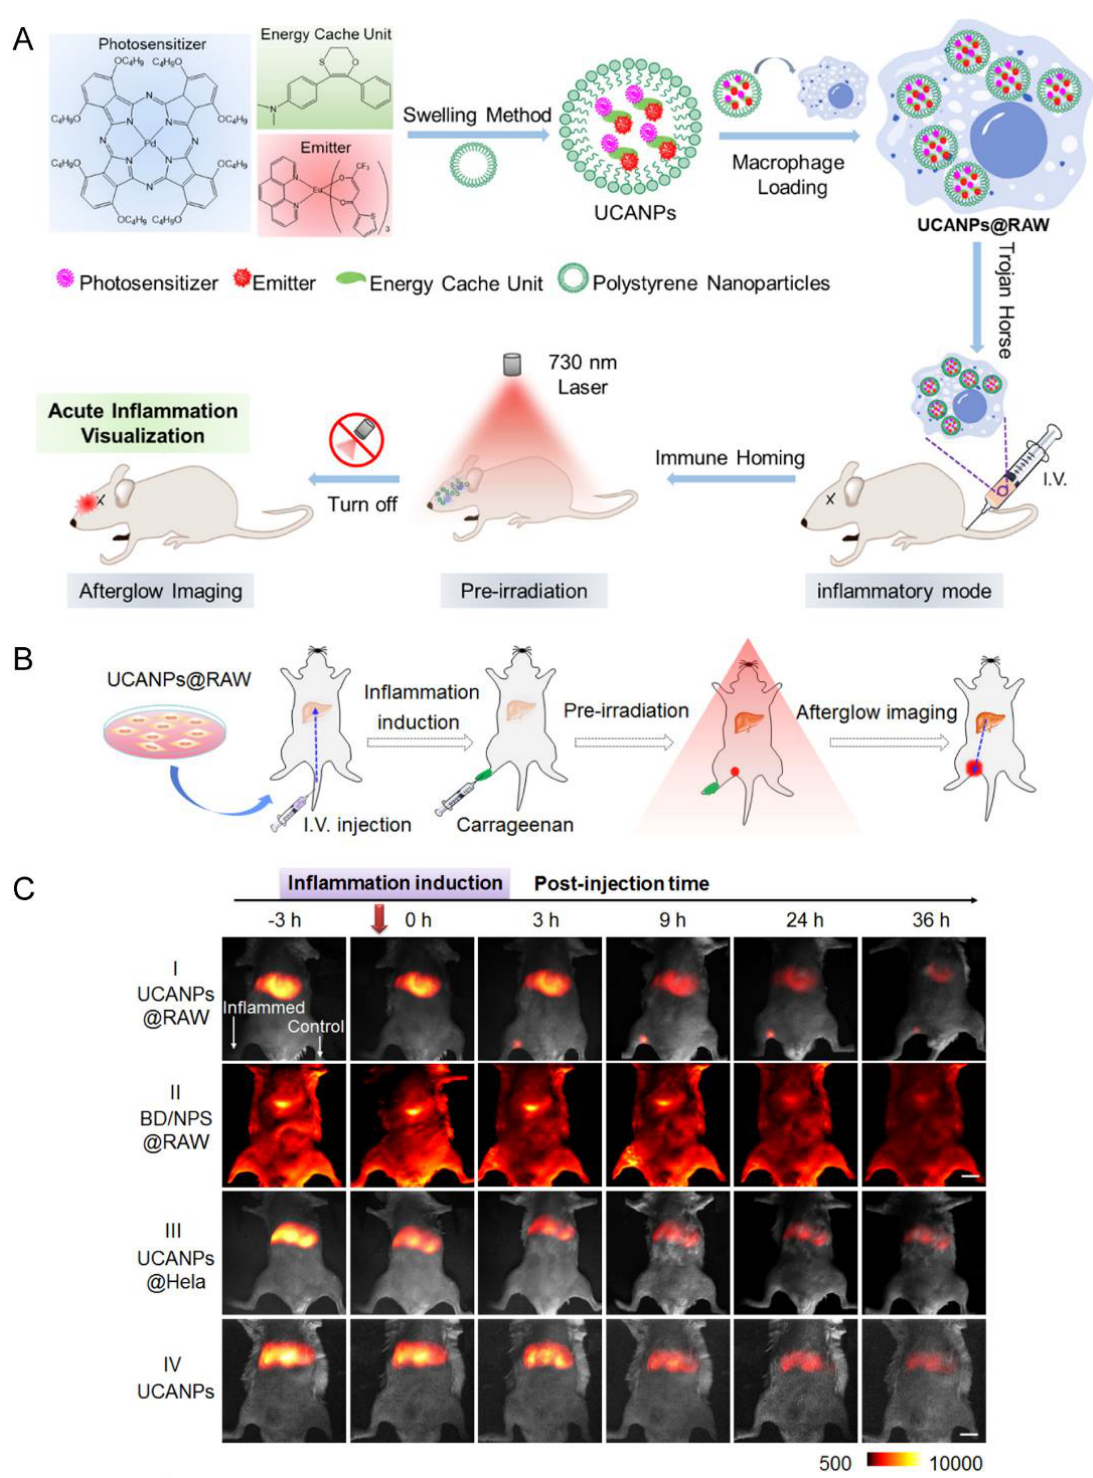
Figure 4. ( A ) Schematic preparation of the UCANPs@RAW for application in visualizing acute inflammation. ( B ) The treatment scheme of UCANPs@RAW. ( C ) In vivo afterglow and fluorescence imaging of UCANPs@RAW in the acute inflammation model. UCANPs, a photochemical afterglow probe; UCANPs@RAW, macrophage-camouflaged afterglow nanocomplex; BD/NPs@RAW, macrophage-camouflaged Bodipy-based nanocomplex; UCANPs@Hela, Hela cell-camouflaged nanocomplex. Reprinted with permission from Ref. [48], Copyright © 2022, American Chemical Society.